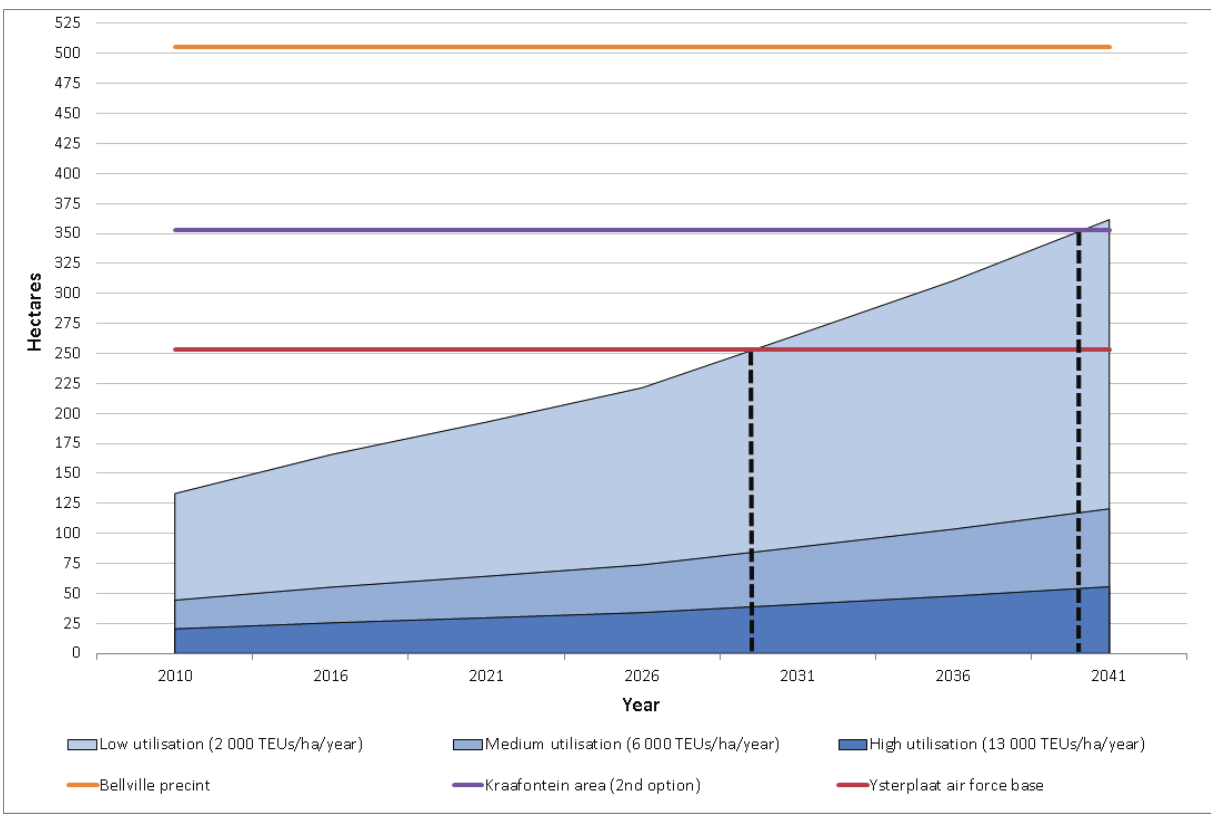
Figure 3: Capacity utilisation of potential locations over time